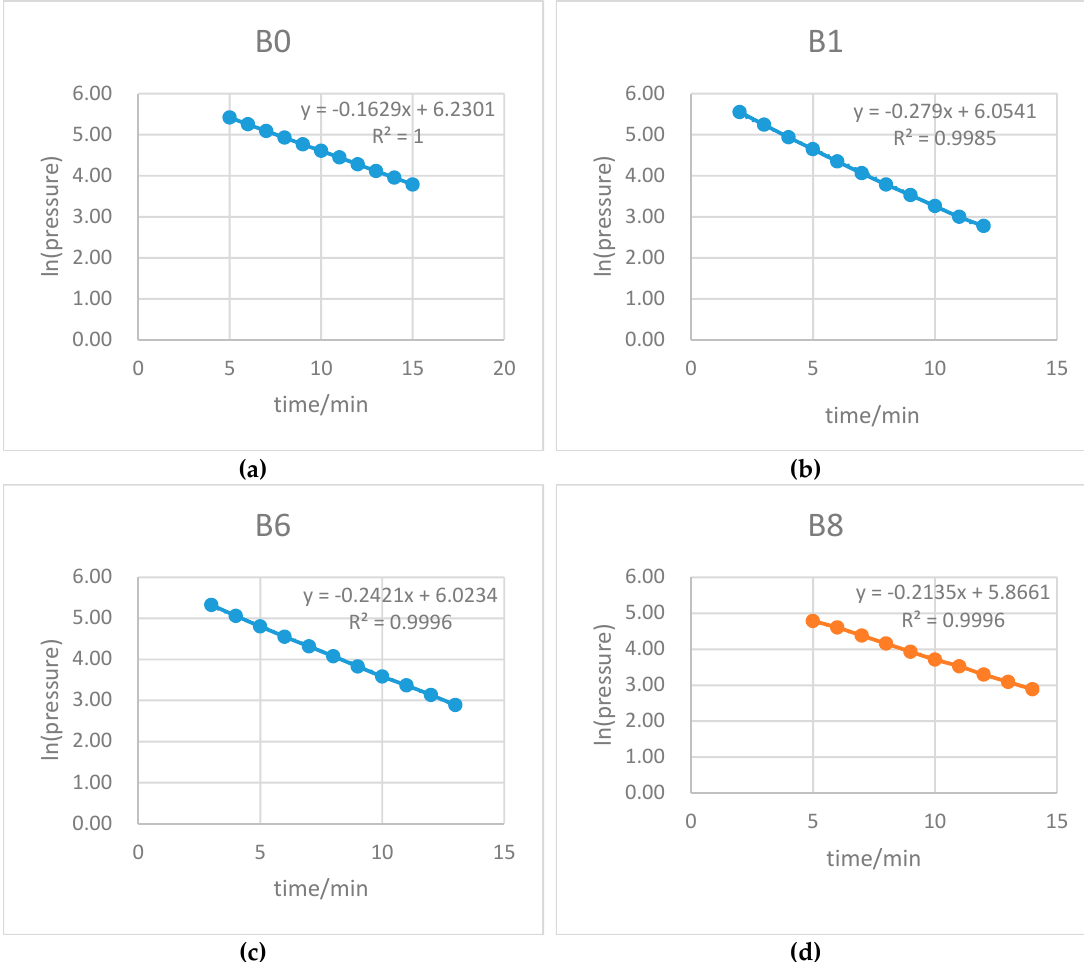
Figure 15. Behaviour of samples during permeability test (W/B = 0.35) for: ( a ) sample B0, ( b ) sample B1, ( c ) sample B6, and ( d ) sample B8.